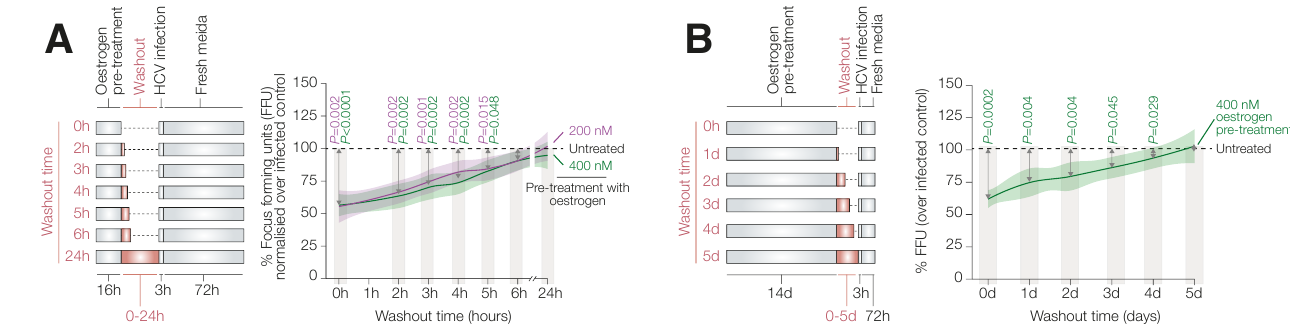
Figure 1. Re-sensitising to infection. ( A ) HuH7 cells were treated overnight with 2 doses of oestrogen and maintained from 0 to 24 h in fresh media (Washout) before infection. Cells were then incubated in fresh media. ( B ) HuH7 cells were treated with oestrogen for 14 days and then maintained from 0–5 days in fresh media (Washout) before infection. Cellular susceptibility to infection was evaluated by FFU count. Data represent at least 3 independent experiments with 2 biological replicates. Values were normalised to the untreated control (dashed line) and presented as mean ± SEM. Statistical significance was evaluated by Mann–Whitney U